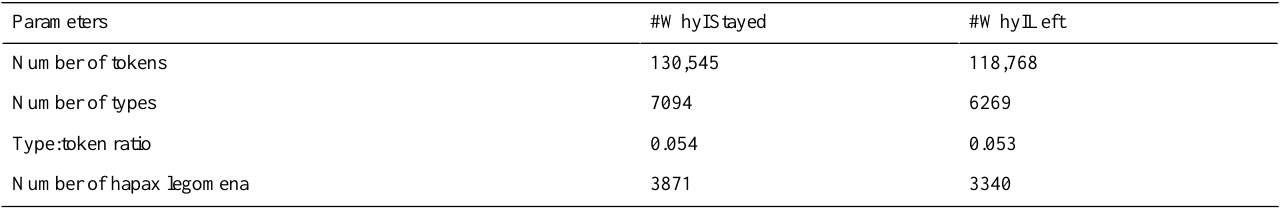
Table 2. Basic lexical statistics on the tokens and types in the two balanced sets. Types are unique tokens whereas hapax legomena are those tokens that only occur once in the data set.